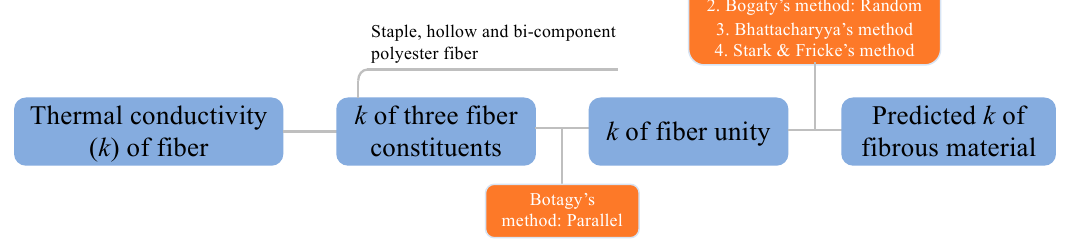
Figure 6. Theoretical study procedures according to fiber thermal conductivity.